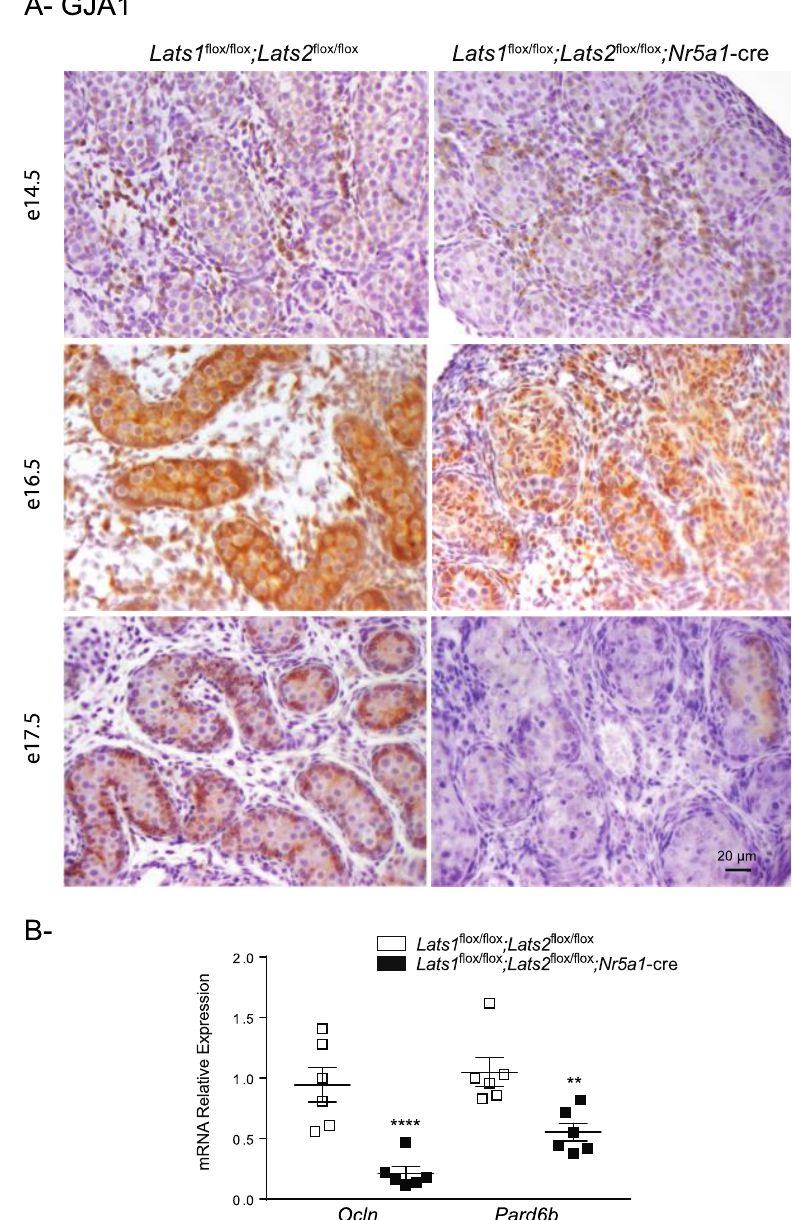
Figure 5. Loss of Lats1 and Lats2 affects the polarity of the Sertoli cells. ( A ) Immunohistochemical analysis of GJA1 expression in testes of mice of the indicated genotypes. Scale bar (lower right) is valid for all images. ( B ) RT-qPCR analysis of Ocln and Pard6b mRNA levels in the testes of 1 dpp mice of the indicated genotypes ( n = 6 animals/genotype). All data were normalized to the housekeeping gene Rpl19 and are expressed as means (columns) ± SEM (error bars). Asterisks = significantly different from control (** p < 0.01; **** p < 0.0001).